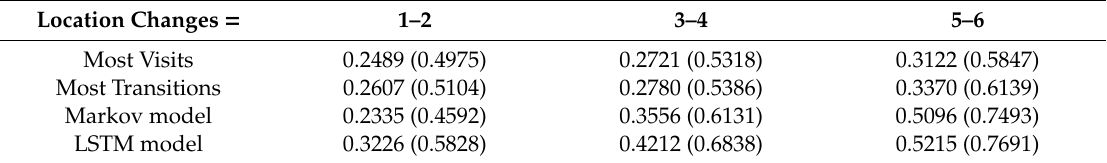
Table 3. Accuracy (and accuracy in top 3 in brackets) comparison for di ff erent numbers of location changes.